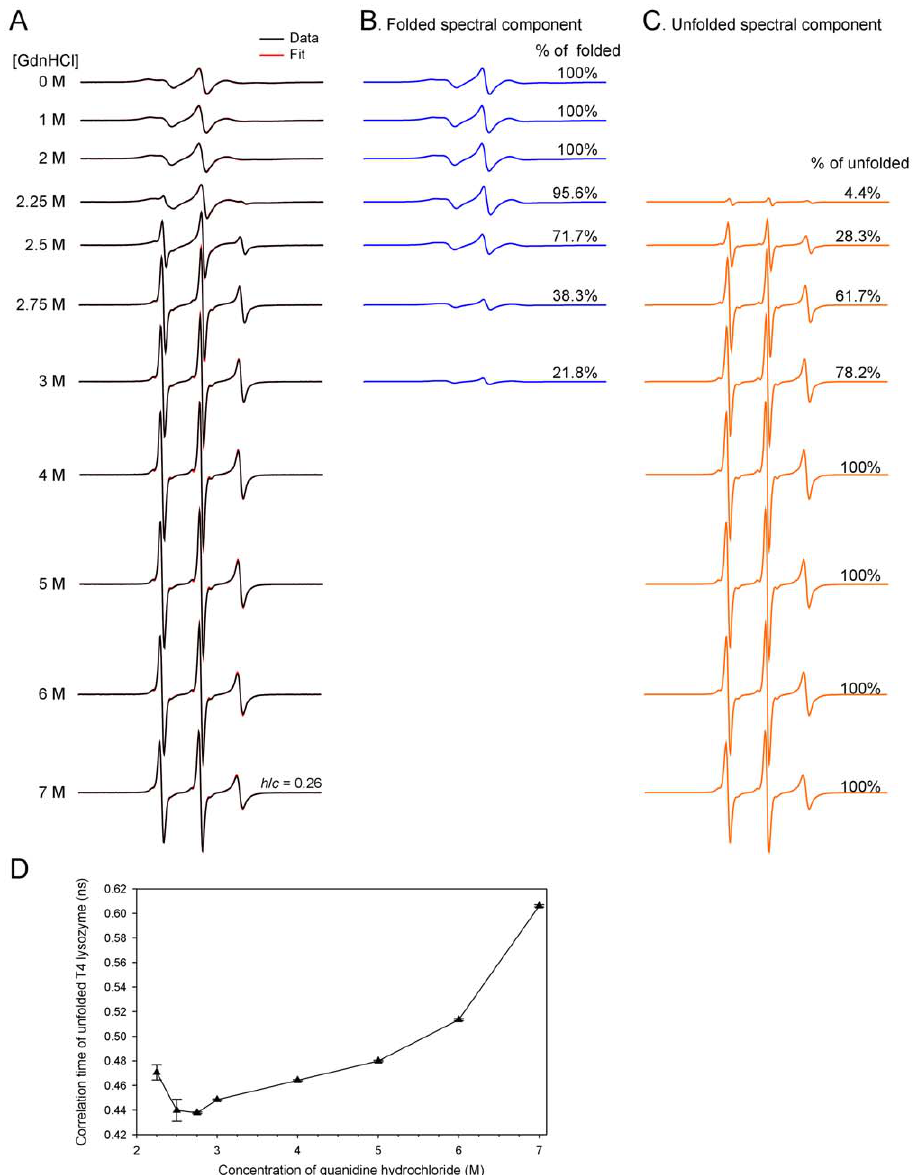
Figure 5. EPR studies of tethered T4 lysozyme D72R1 in denaturing conditions. (A) The EPR spectra of tethered T4L D72R1 in various concentrations of GdnHCl. The experimental spectra are shown in black and the best non-linear least squares fits are shown in red. The h/c ratio for the 7 M GdnHCl spectrum is calculated for comparison with those of spin-labeled Ure2p 1–89 -M. (B,C) Individual spectral components for the folded state (B) and unfolded state (C) from spectral simulations. (D) Plot of correlation time of the unfolded state from spectral simulations versus GdnHCl concentration. Note that there is a decrease in correlation time (i.e., increase in protein flexibility) when GdnHCl concentration is increased from 2.25 M to 2.75 M, suggesting that there are some residual structures in this GdnHCl concentration range. Further increase in GdnHCl concentration beyond 3 M led to a monotonic increase in correlation time, suggesting that the major effects in the GdnHCl concentration range of 3–7 M are the viscosity effect that slows down protein motion. For simulation of the T4L spectra, an anisotropic motional parameter to account for the effect of solvent polarity on A 0 , but model was used for the folded state and an isotropic motion was varying A 0 does not affect R . Rotational correlation time ( t ) was used for the unfolded state. For anisotropic simulations, diffusion calculated from t = 1/(6 R ). One and two component fits were tilt angles were fixed to ( a , b , c )= (0,36 u ,0) for z -axis anisotropy as performed. We found that using two spectral components did not previously reported [31]. The diffusion tilt angels are the Euler significantly improve the fit, and the parameters of the two angles relating the axes of the diffusion tensor and the magnetic components often converge to one set of values. Therefore, we tensor. For the folded state, R, A 0 , and an order parameter ( S ) were concluded that there is only one spectral component in all the simulated spectra as indicated in the text. Values of t obtained allowed to vary. For the unfolded state, R and A 0 were used as from simulation are plotted in the figures. variable parameters.